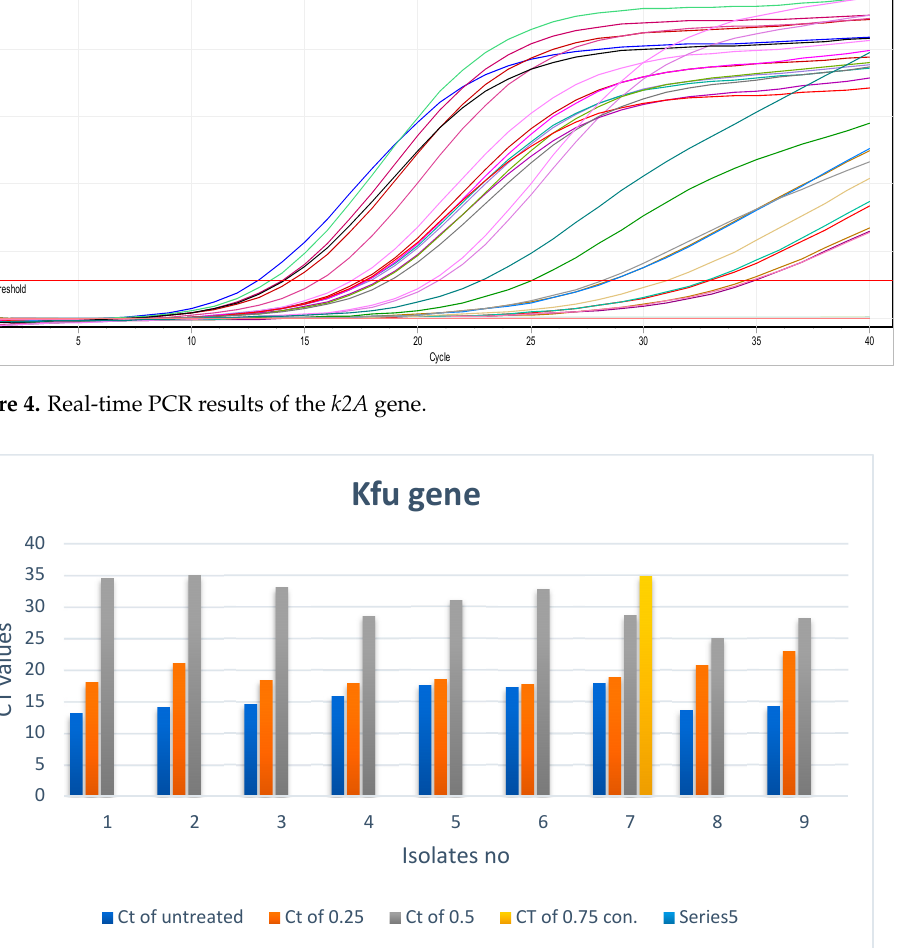
Figure 5. kfu gene expression in Klebsiella pneumoniae isolates treated with different concentrations of ZnO nanoparticles.